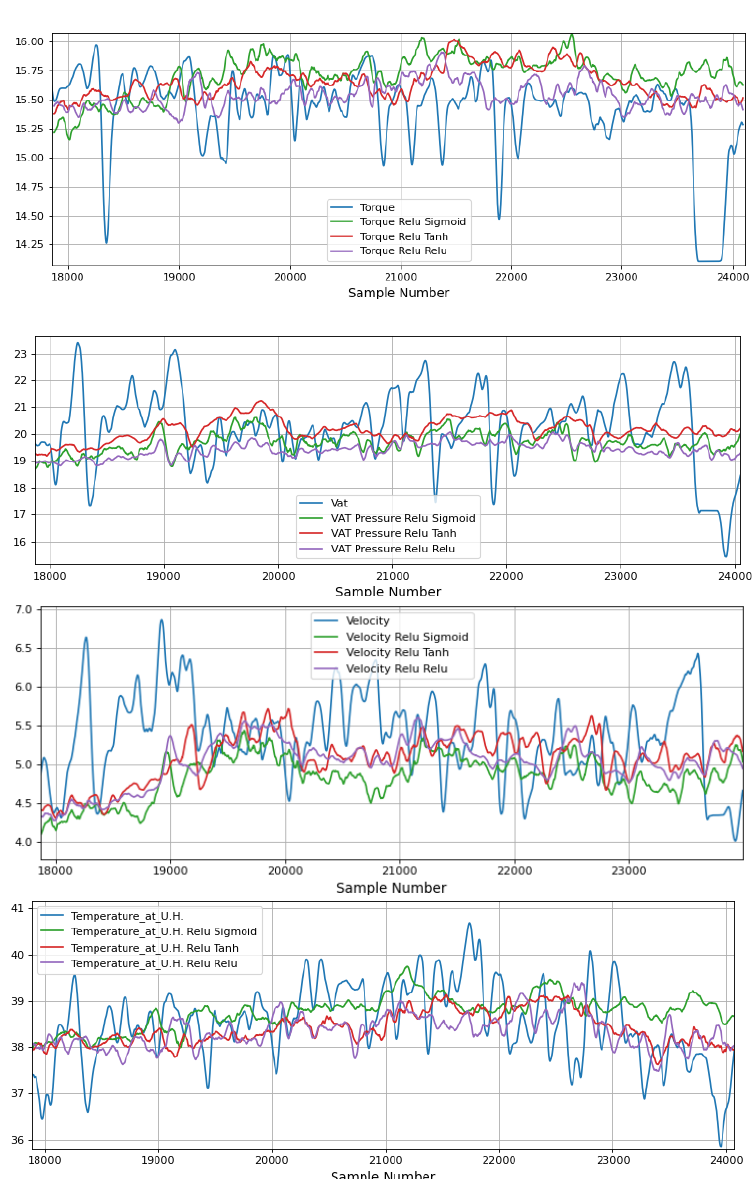
Figure 19. Plot of the predictions with different combinations of activation